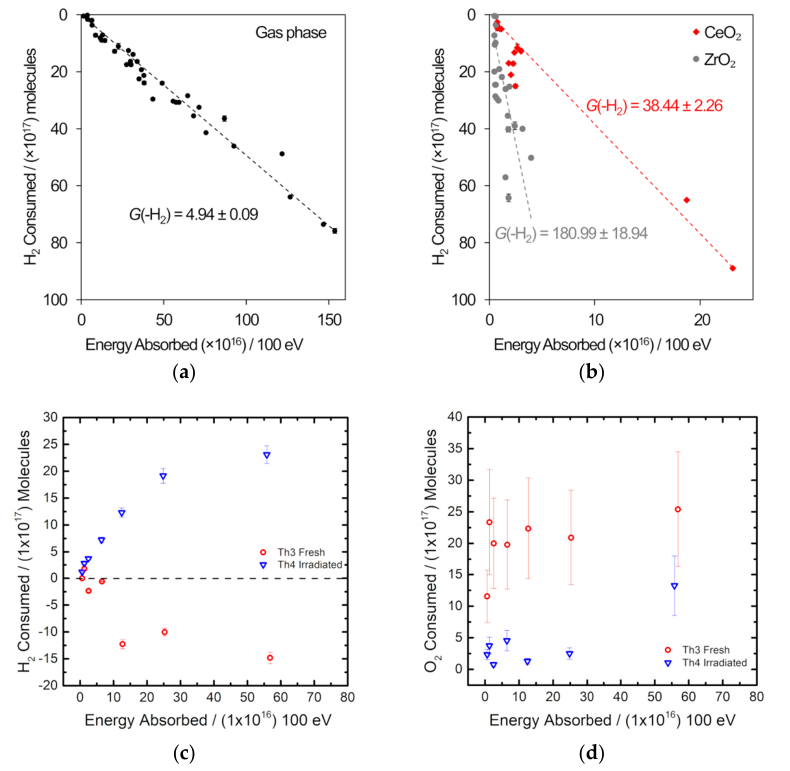
Figure 6. Gas radiolysis experiments using gamma radiation with analysis by gas chromatography. ( a ), ( b ) H 2 consumption in a 5:5:90 H 2 -O 2 -Ar atmosphere. ( a ) is the gas phase only and ( b ) is in the presence of CeO 2 and ZrO 2 [23]. ( c ) and ( d ) are from a 1:1:98 H 2 -O 2 -Ar atmosphere irradiated over 8 g of thoria and show the change in H 2 and O 2 , respectively [35].